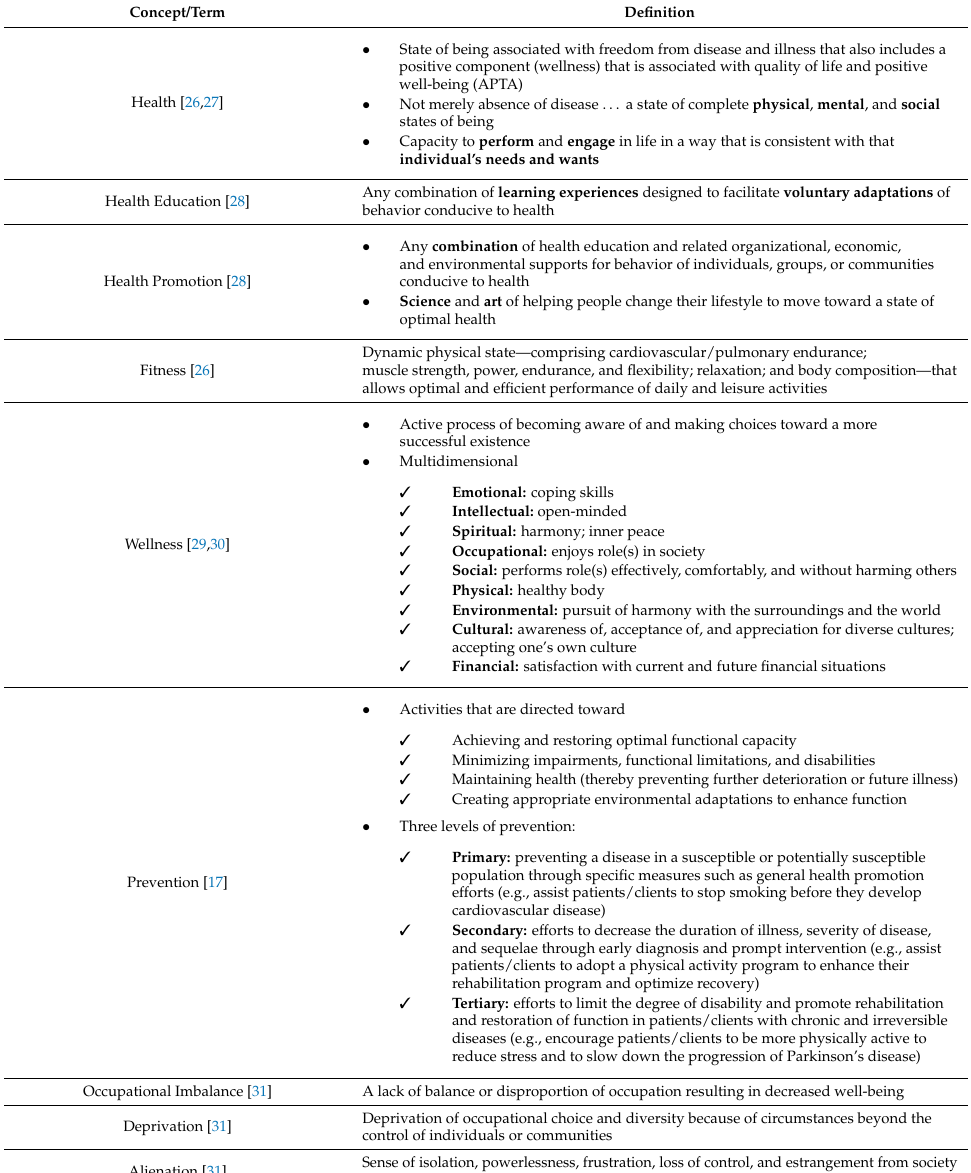
Table 3. Critical health promotion and wellness (HPW) concepts and